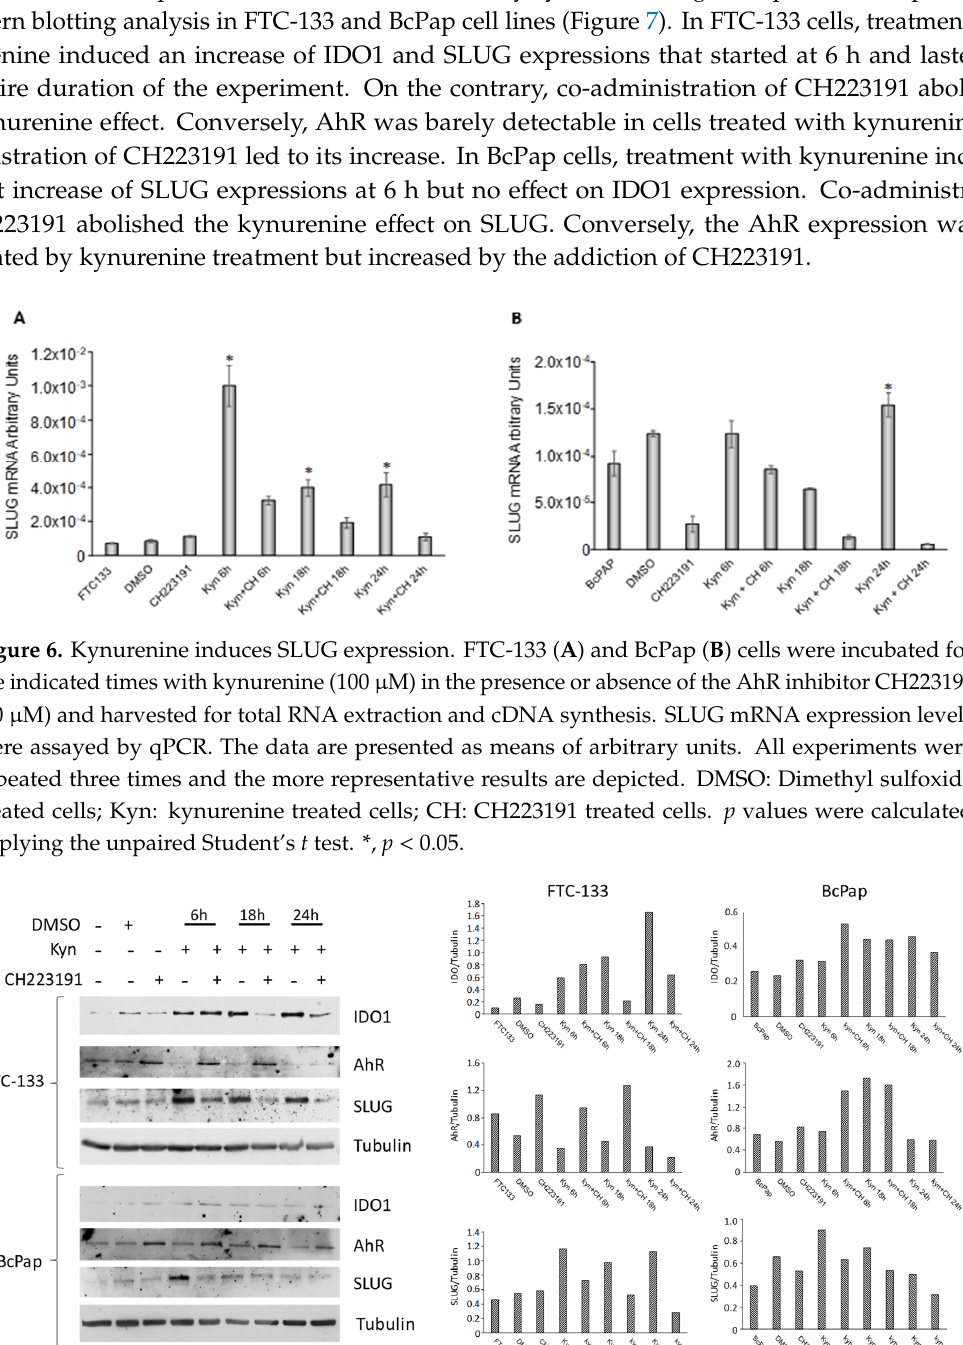
Figure 7. Effects of kynurenine on IDO1, AhR and SLUG protein levels. FTC-133 and BcPap cells were incubated for the indicated times with kynurenine (100 µM) in the presence or absence of the AhR inhibitor CH223191 (10 µM) and harvested for protein extraction. Expression of IDO1, AhR, SLUG and tubulin were assayed by immunoblot. All the experiments were repeated twice, and the more representative results are depicted. The bands of the shown experiment were analyzed by densitometry and normalized with tubulin. DMSO: Dimethyl sulfoxide treated cells; Kyn: kynurenine treated cells; CH: CH223191 treated cells.